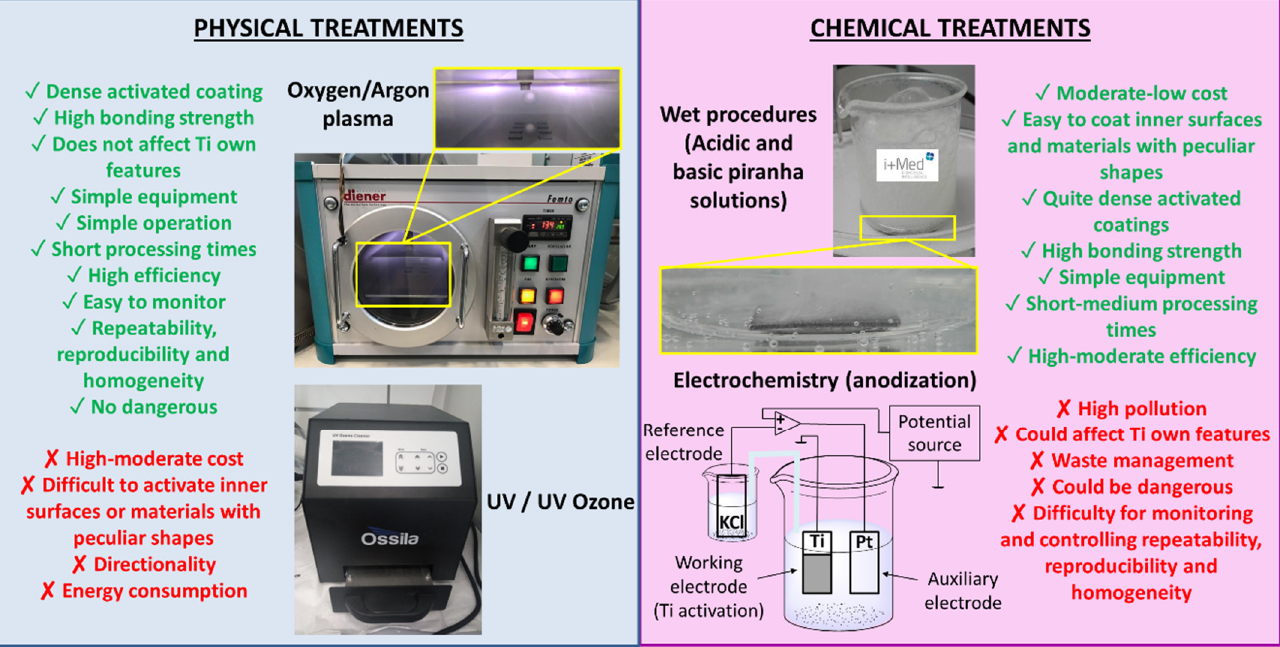
Figure 2. Different physical and chemical treatments for activation of Ti surface with their advantages (green) and disadvantages (red).